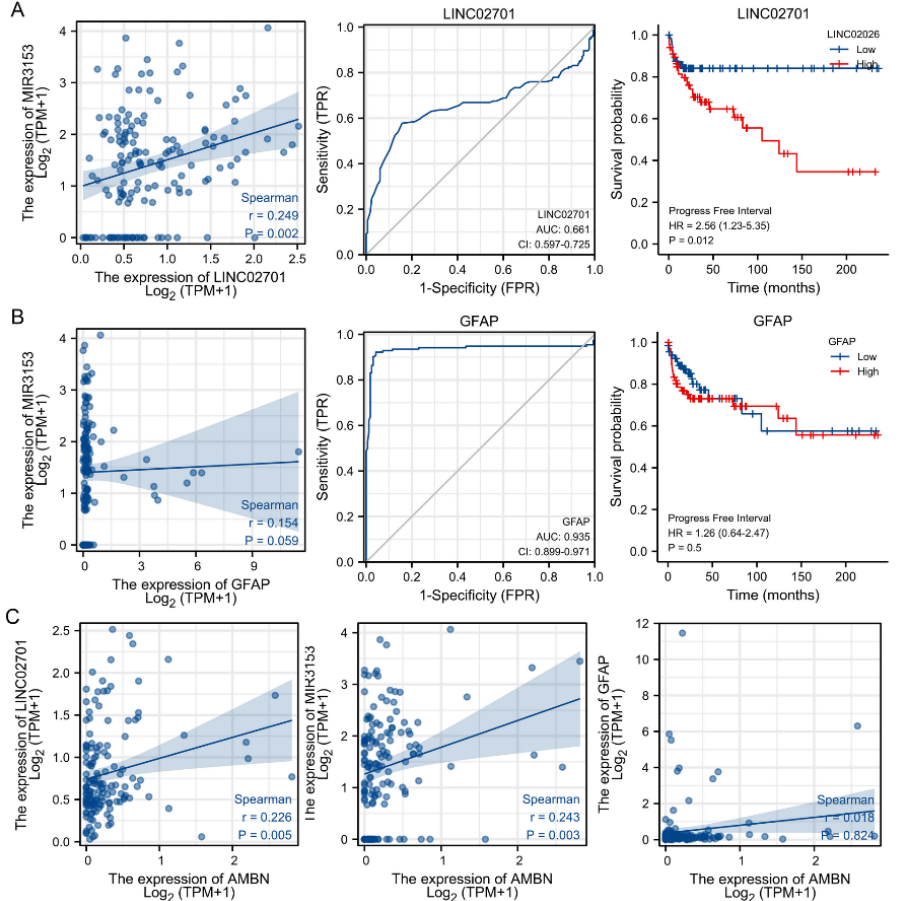
Figure 6. Correlation analysis of ceRNA network ( A ) Correlation analysis of LINC02701 with has- miR3153, ROC and KM curves analysis of LINC02701 with TGCT diagnosis and PFI ( B ) Correlation anal- ysis of GFAP with has-miR3153, ROC and KM curves analysing the significance of GFAP with TGCT diagnosis and PFI ( C ) Correlation analysis between AMBN and LINC02701, has-miR-3153, and GFAP.